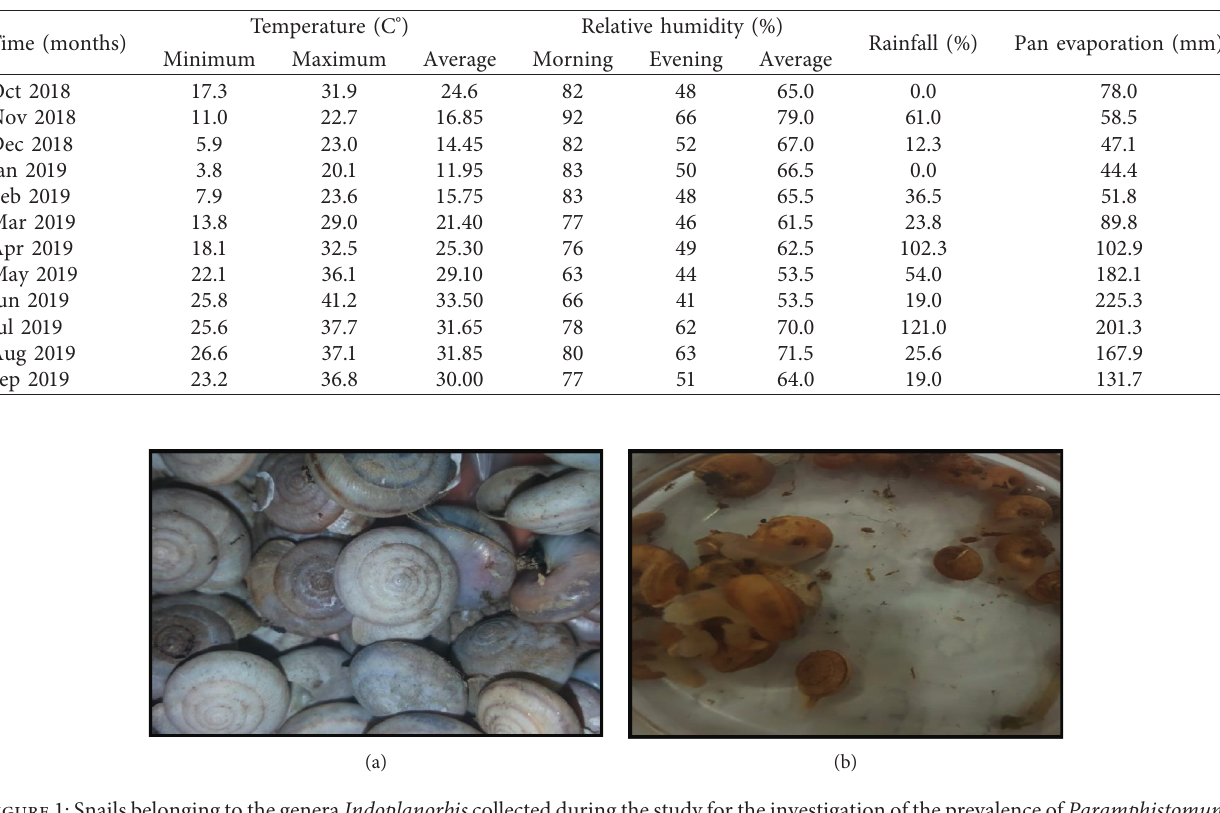
Table 1: Mean monthwise temperature ( ° C), relative humidity (%), rainfall (mm), and pan evaporation (mm) during the study period in the adjacent districts of Khyber Pakhtunkhwa (October 2018 to September 2019).